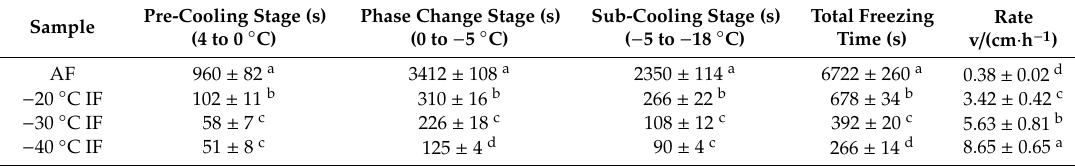
Table 1. Freezing rate and freezing time distribution for each freezing stage under di ff erent conditions.